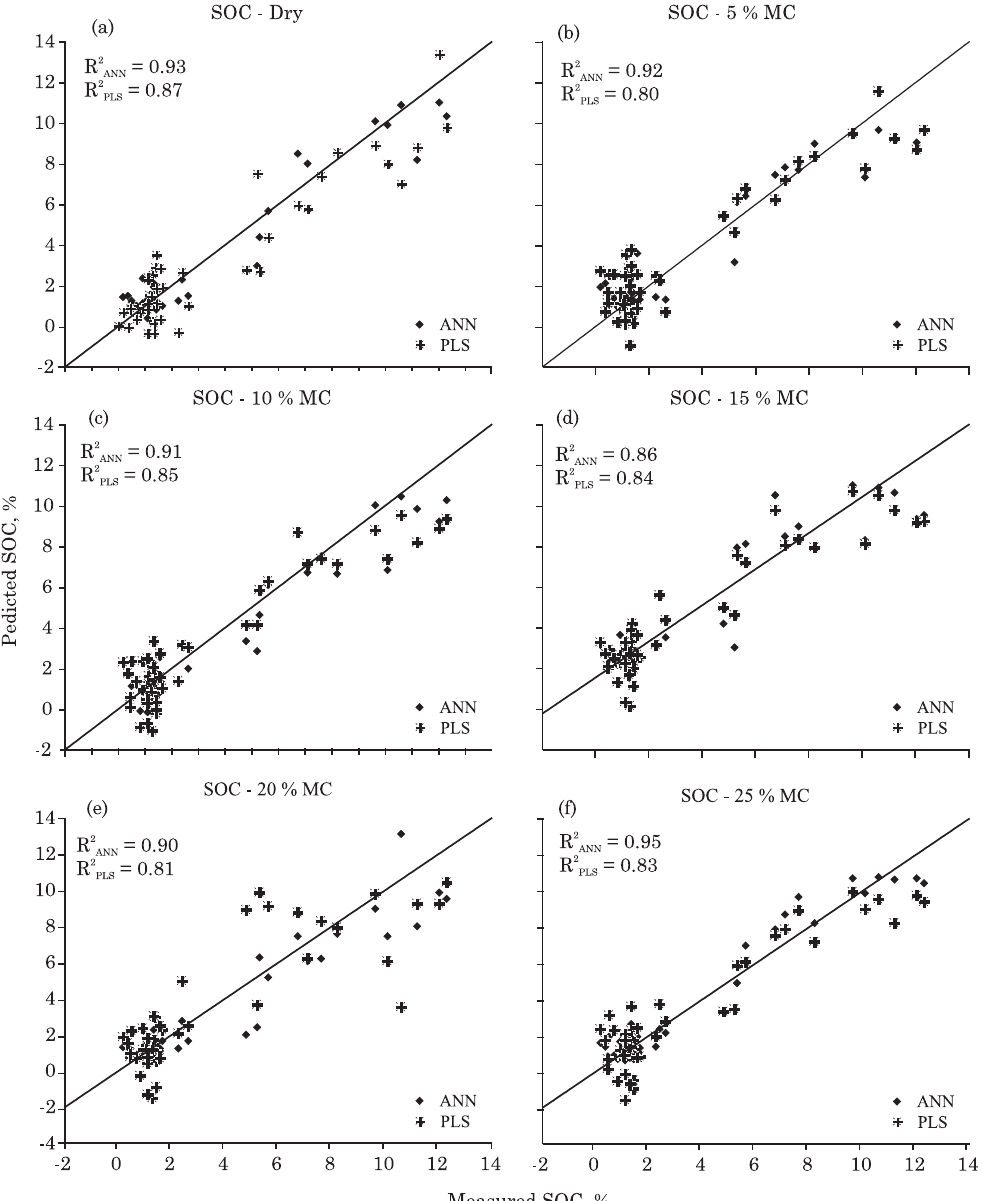
Figure 1. Effect of moisture content (MC) and calibration technique on R 2 of soil organic carbon (SOC) prediction with partial least squares (PLS) and the artificial neural network